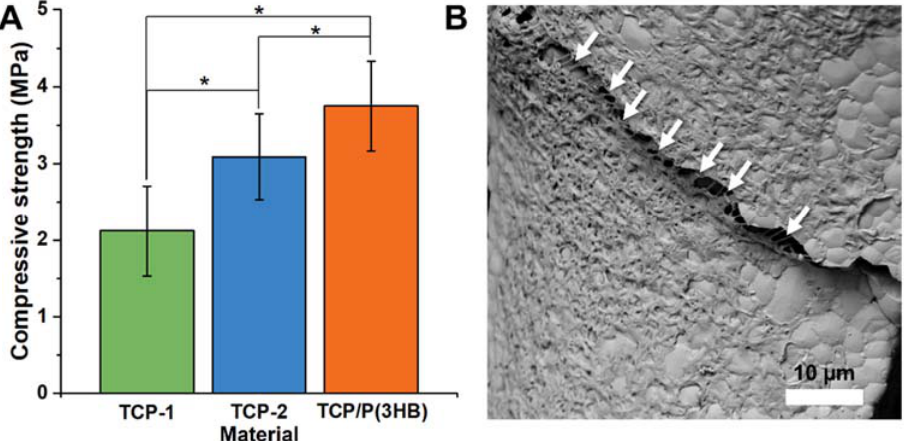
Figure 5. The compressive strength of the scaffolds ( A ) TCP-1, TCP-2, TCP/P(3HB) and ( B ) SEM microphotograph of TCP/P(3HB) after compressive test. Arrows indicate polymeric microfilaments connecting ceramics’ cracks. Statistically significant differences were indicated by * p ≤ 0.01.